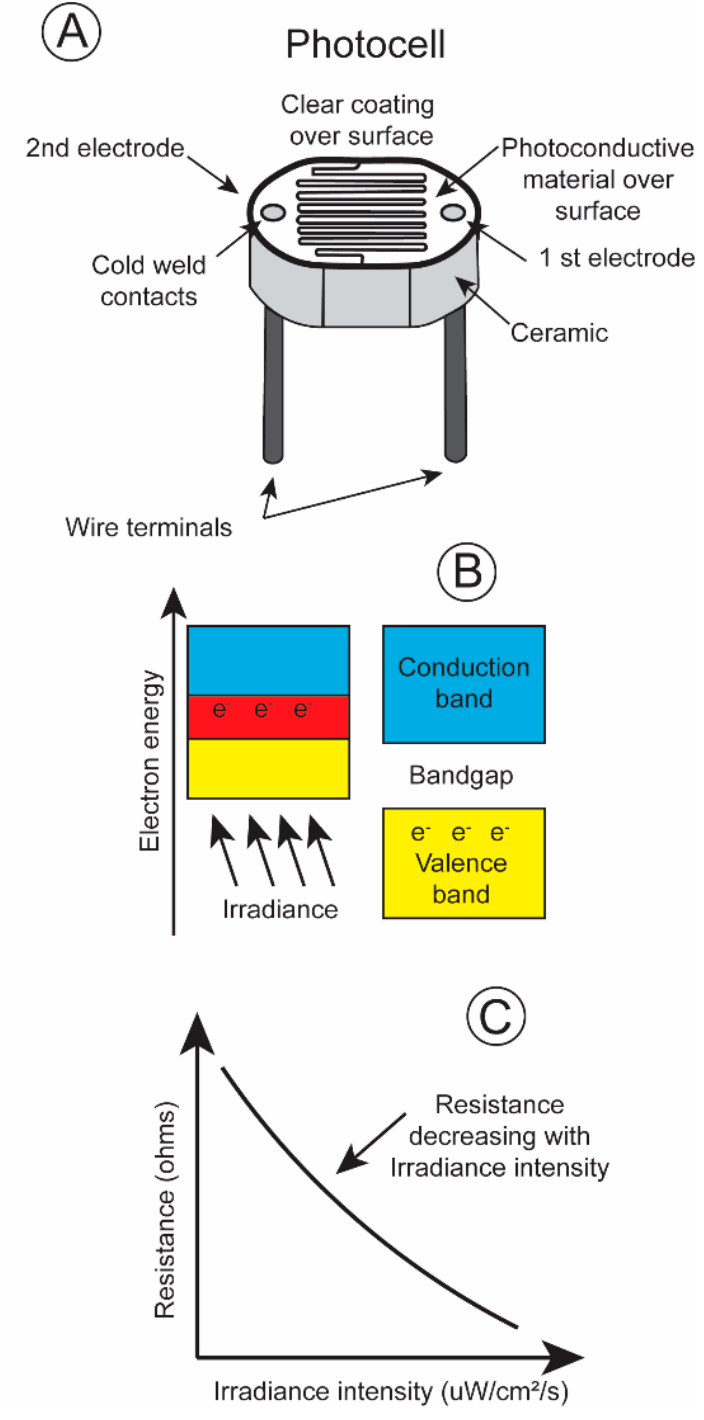
Figure 4. ( A ) Diagram of photocell; ( B ) explanation of operation; ( C ) plot of resistance change as a function of increasing irradiance level [13].